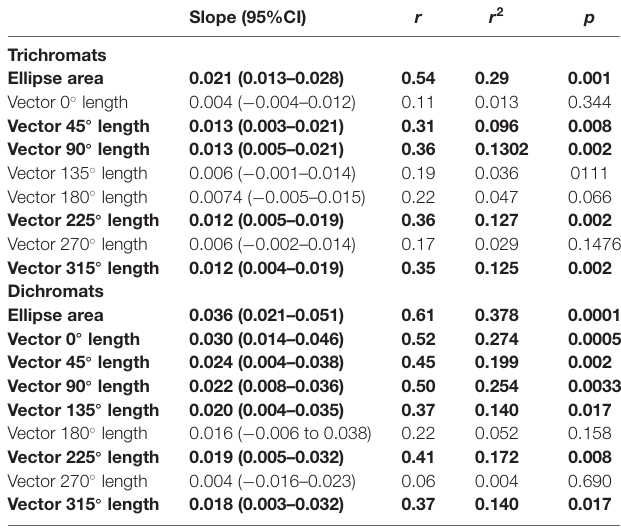
TABLE 1 | Results of the linear regression between chromatic thresholds and luminance noise amplitude.